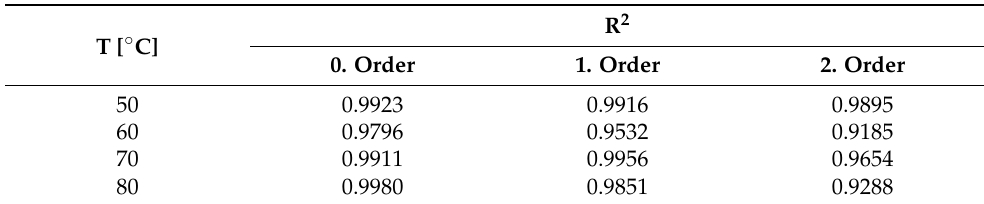
Table 6. Kinetic models for Lf degradation along with corresponding determination coefficients (R 2 ) under various temperatures.